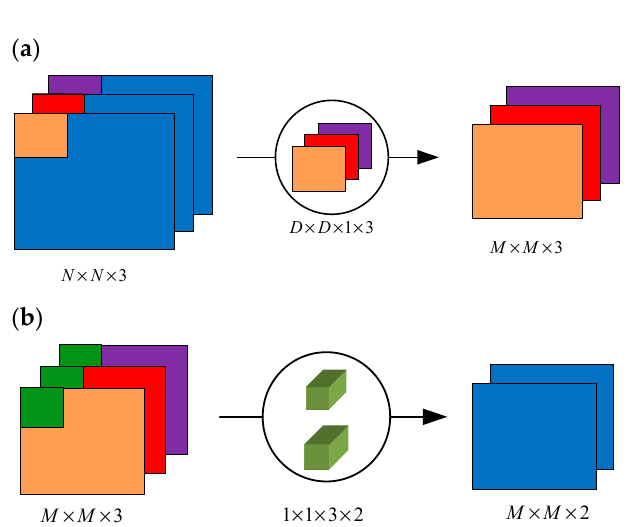
Figure 4. Depthwise separable convolution: ( a ) DWCnov and ( b ) PWConv.